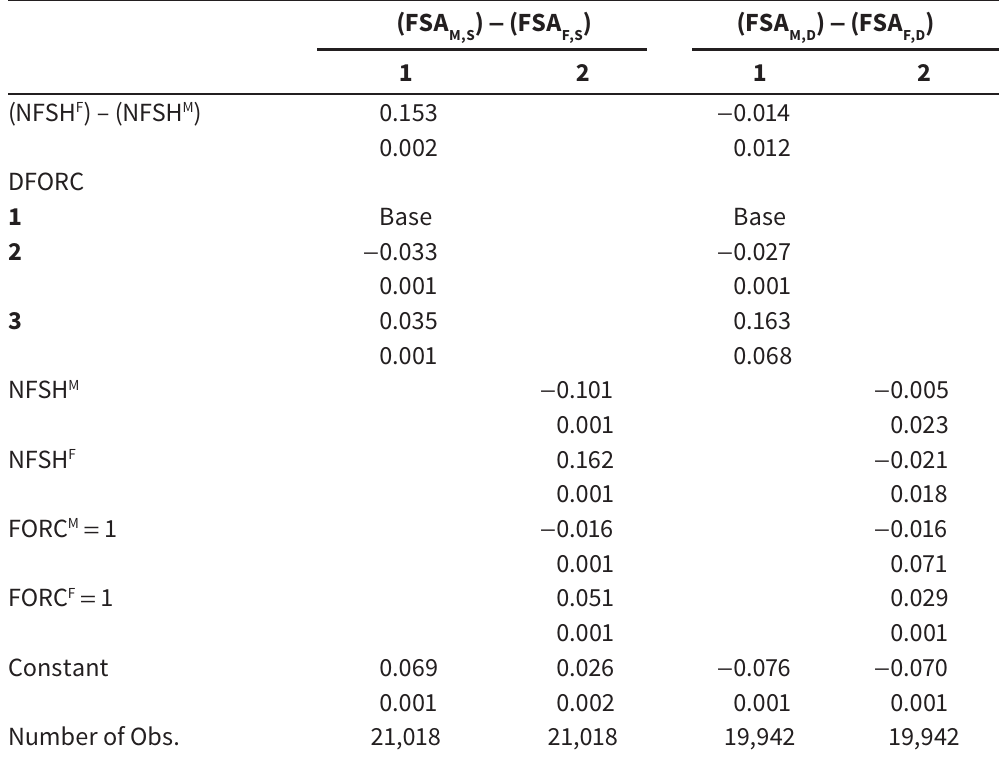
Transmission of field of study by within-family specification with 41 major CIP